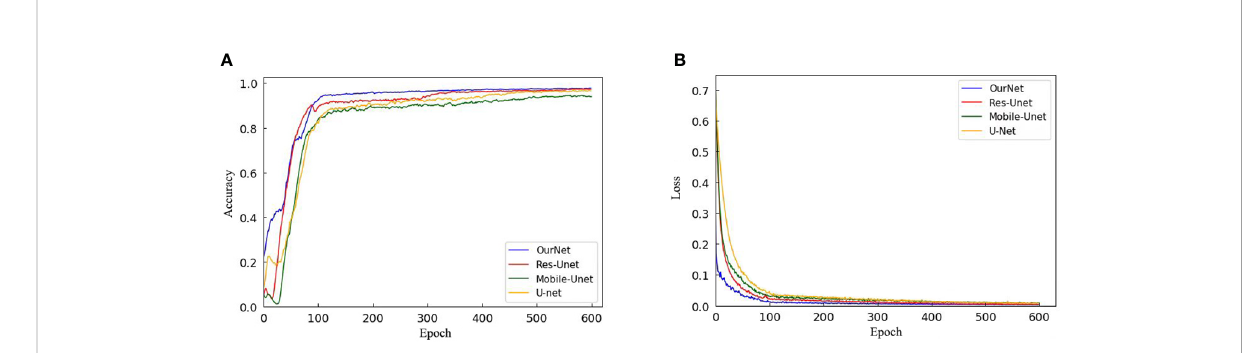
FIGURE 9 Comparative experiment of training process: (A) Conversion curve of each model during training; (B) Loss function transformation curve of each